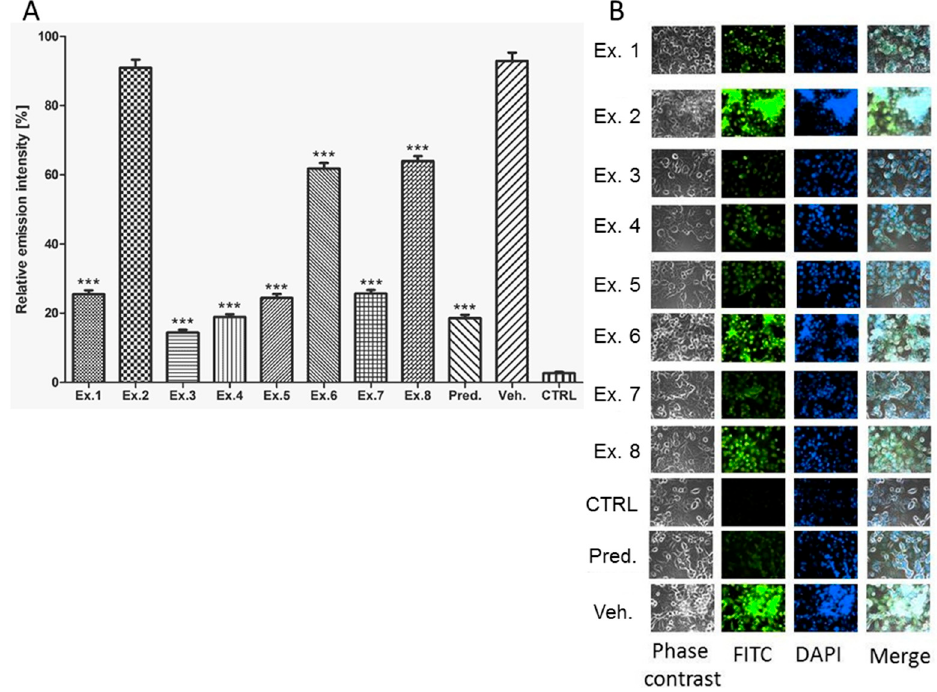
Figure 3. Graphical comparison of inhibitory activity of Scorzonera species on NF- κ B activation. The cells were pre-treated with extracts 1–8 (Ex. 1–8) (25 µ g/mL), and prednisone (1 µ M), or the vehicle (DMSO) only. After 1 h of the incubation, the inflammatory response was induced by LPS [except of the control cells (CTRL)]. The NF- κ B activation was measured 3 h after the LPS addition. The results are expressed as mean ± SE for three independent experiments ( A ) and quintessential pictures obtained by fluorescent camera ( B ). *** Significant difference in comparison to vehicle only treated cells ( p < 0.001).